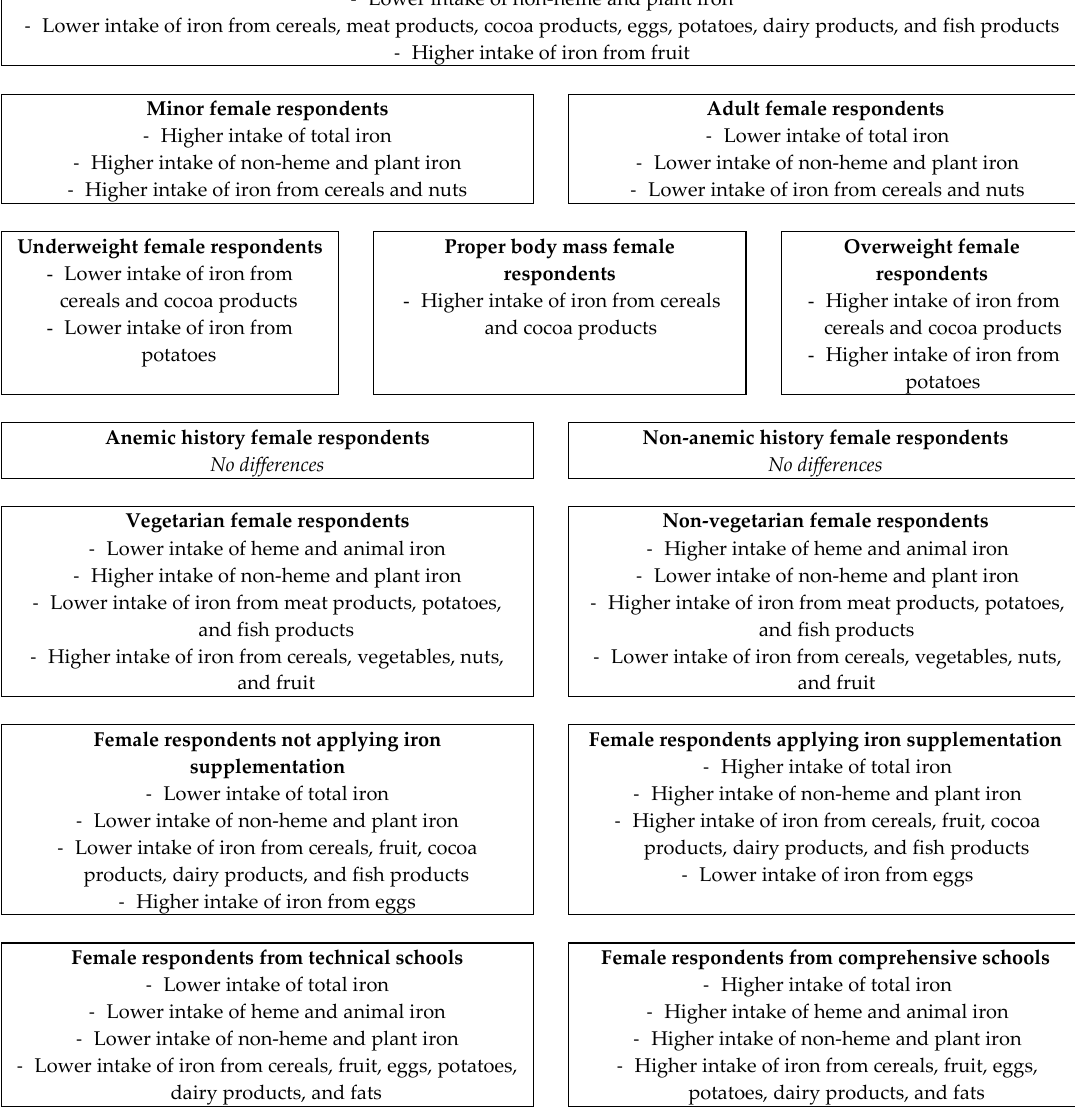
Figure 2. Summary of the presented results. Table 9. Share of individuals characterized by adequate or inadequate iron